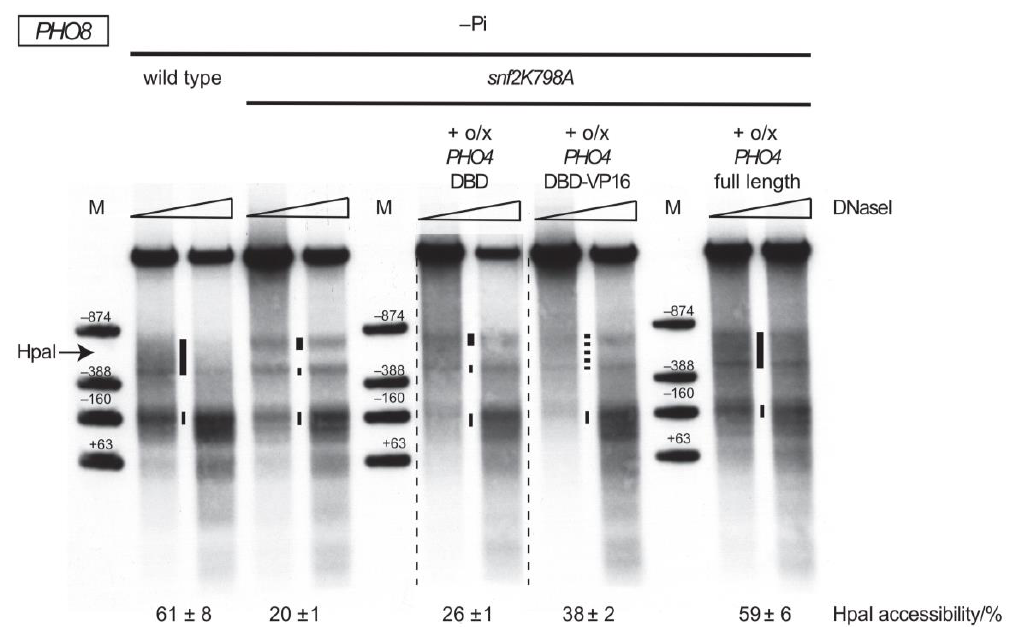
Figure 4. PHO8 promoter opening in the absence of SWI/SNF activity by PHO4 overexpression depends on the Pho4 activation domain. DNaseI indirect end labeling and corresponding HpaI accessibility values analogous to Figure 1B,C for the indicated genotypes and growth conditions. Short dashed vertical bar denotes not fully hypersensitive region. Thin dashed vertical lines, as in Figure 3. The condition – Pi snf2K798A + o/x PHO4 full length is a technical replicate of the condition ‒Pi snf2K798A + o/x PHO4 shown in Figure 3.